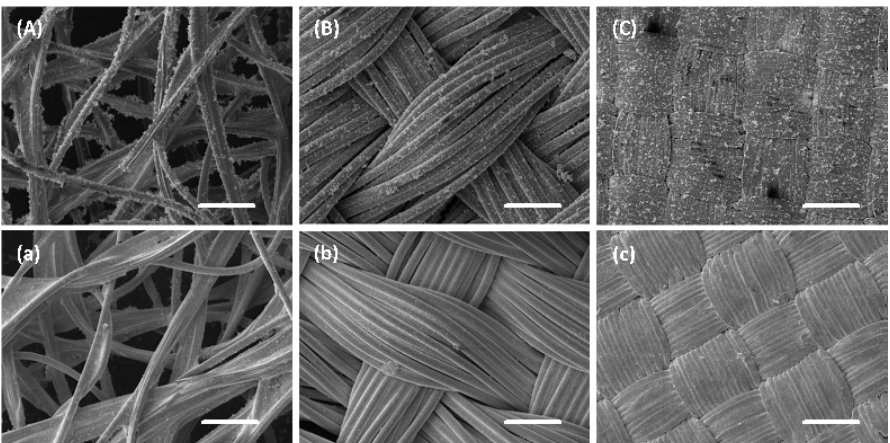
Figure 2. SEM images of copper-plated textiles consisting of 55% of viscose and 45% polyester ( A ), 100% polyestersulfone ( B ), a taffeta lined and calendered polyamide textile ( C ) and the corresponding fabrics (A-a, B-b and C-c) with Ni plating in ( a – c ). Scale bar for all the images: 100 µ m.